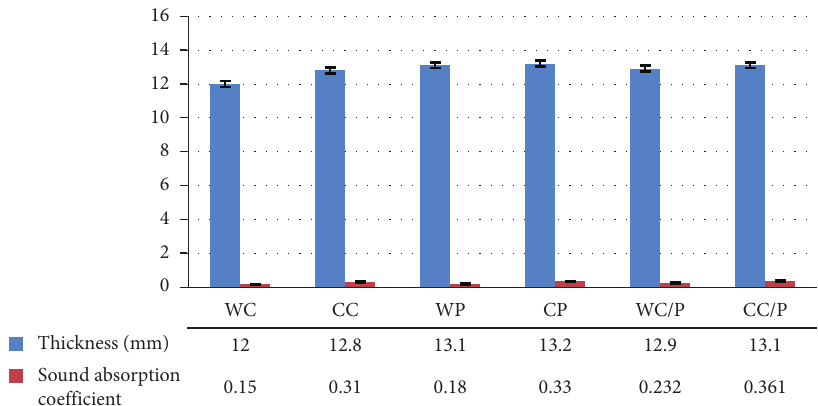
Figure 6: Influence of thickness on sound absorption coefficient.